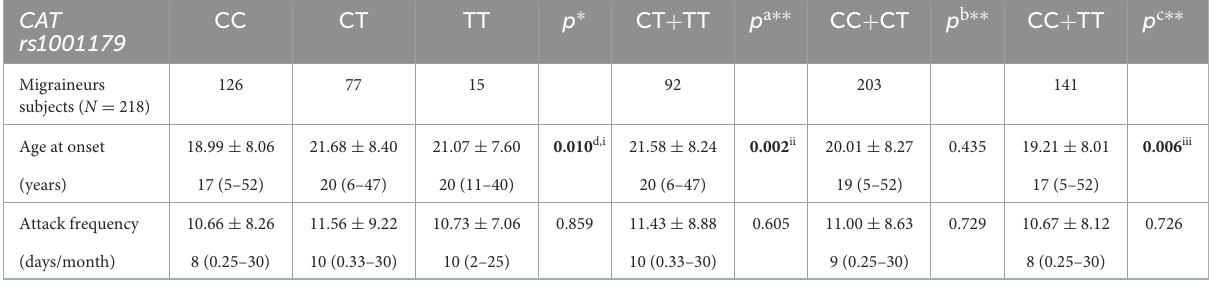
TABLE 5 Analysis of the CAT rs1001179 variant association with clinical features in migraineurs.